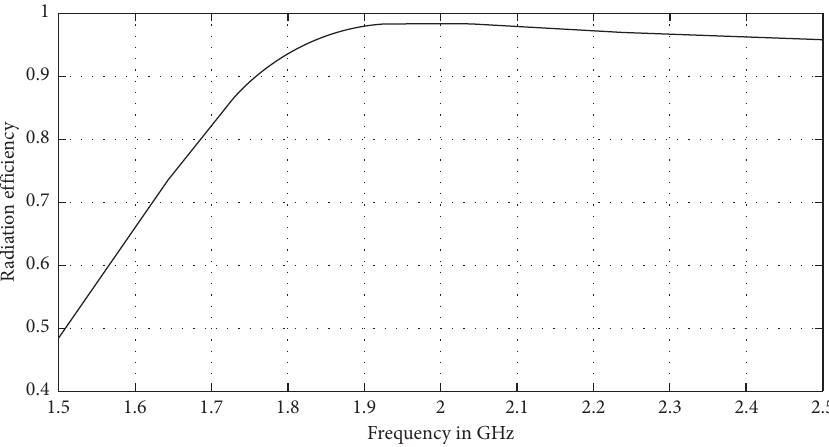
Figure 8: Antenna radiation